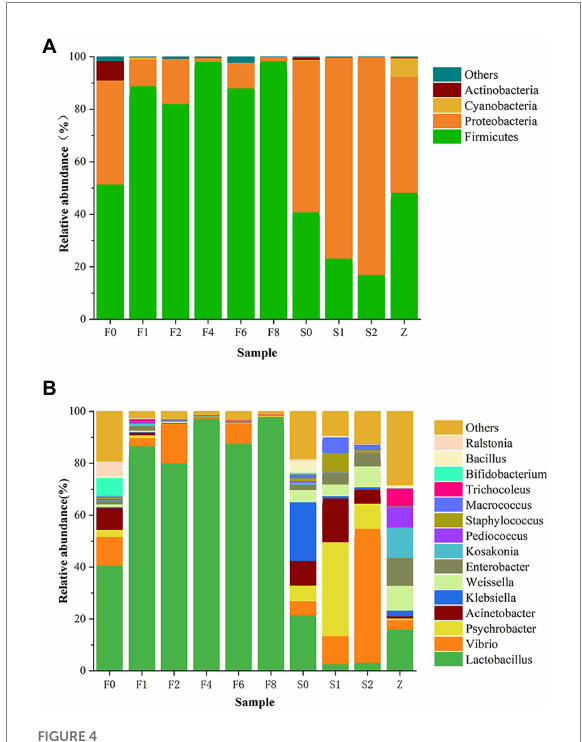
FIGURE 4 Relative abundance at the phylum level (A) and the genus level (B) of bacterial community.